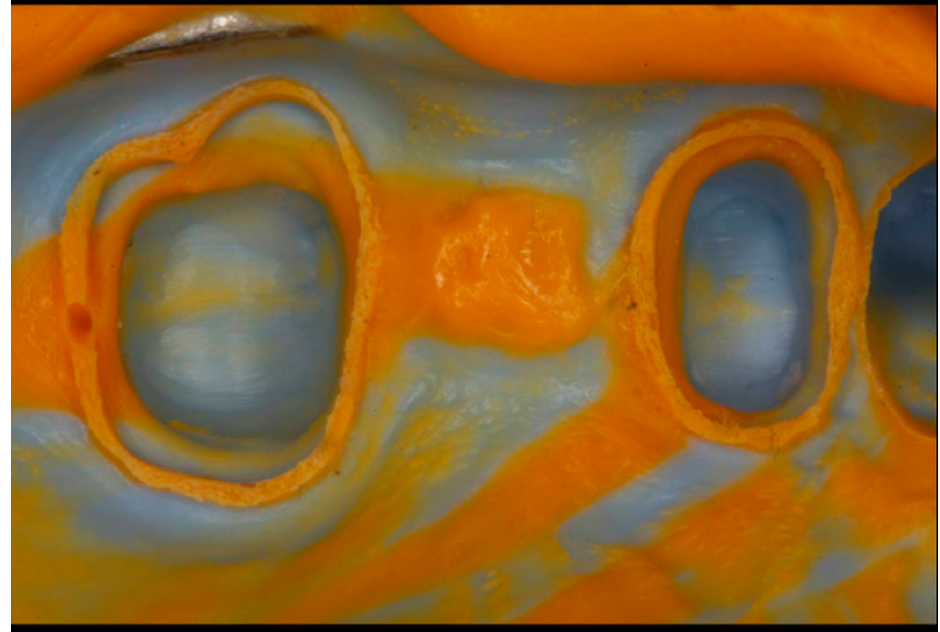
Figure 1. One-step impression technique.